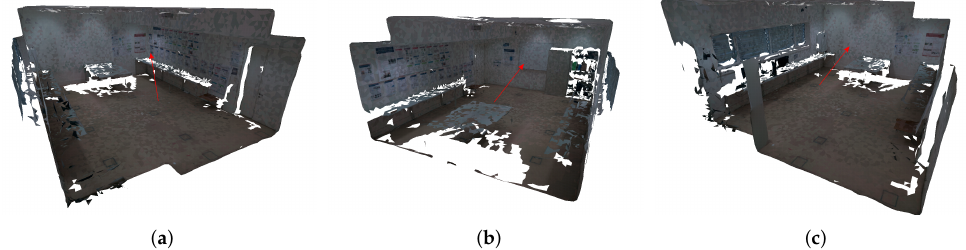
Figure 11. The three viewpoints analyzed in the mesh-based qualitative evaluation. The viewpoints are exemplified in the textured mesh produced by the baseline algorithm (#1) using the random image selection criterion. ( a – c ) Red arrows point out the parts of the 3D mesh where the viewpoints 1, 2, and 3 were taken,